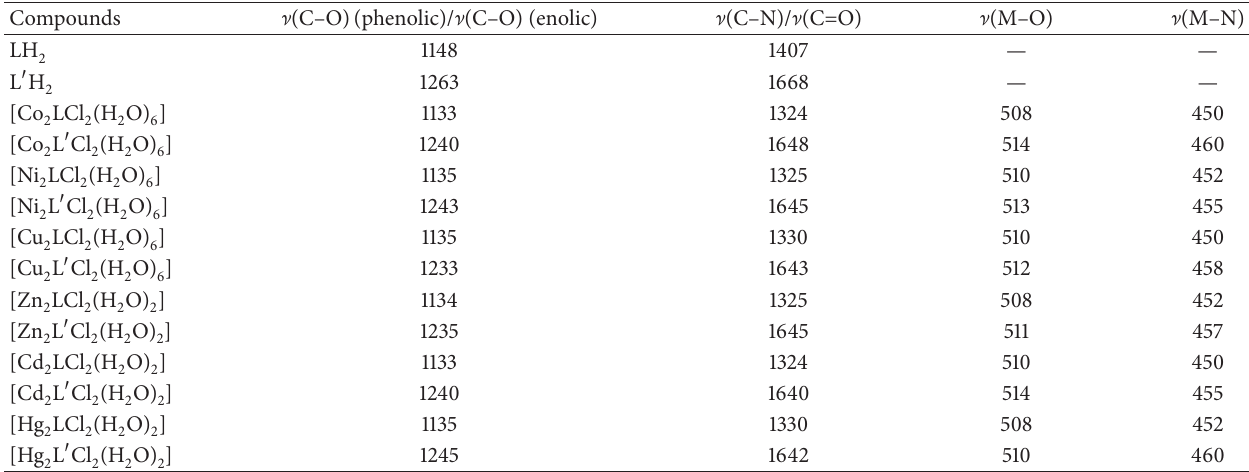
Table 2: Infrared spectra of the ligand and the complexes in cm −1